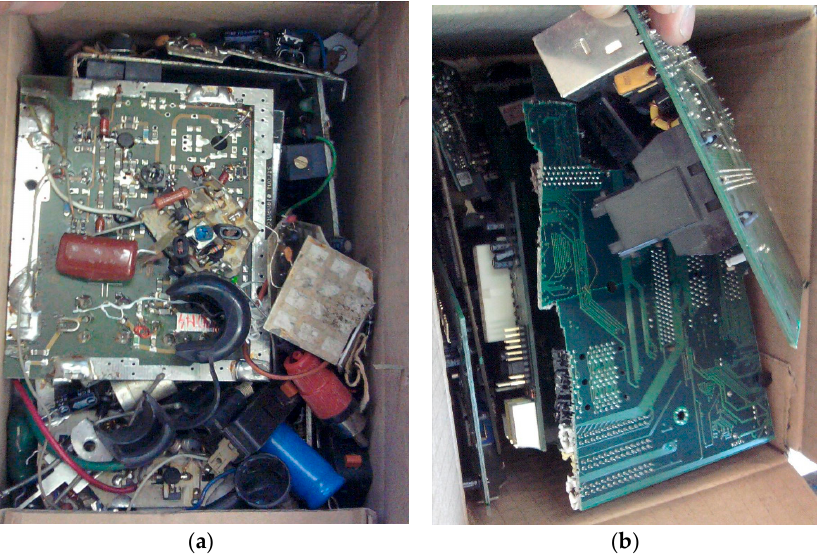
Figure 5. Waste printed circuit boards used in experiments. ( a ) Picture presents circuits and other mixed waste components used in experiment no. 2; ( b ) Picture presents PCB from personal computers used in experiments no. 1 and no. 3. Table 3. Input waste mass in experiments. Table 3. Input waste mass in